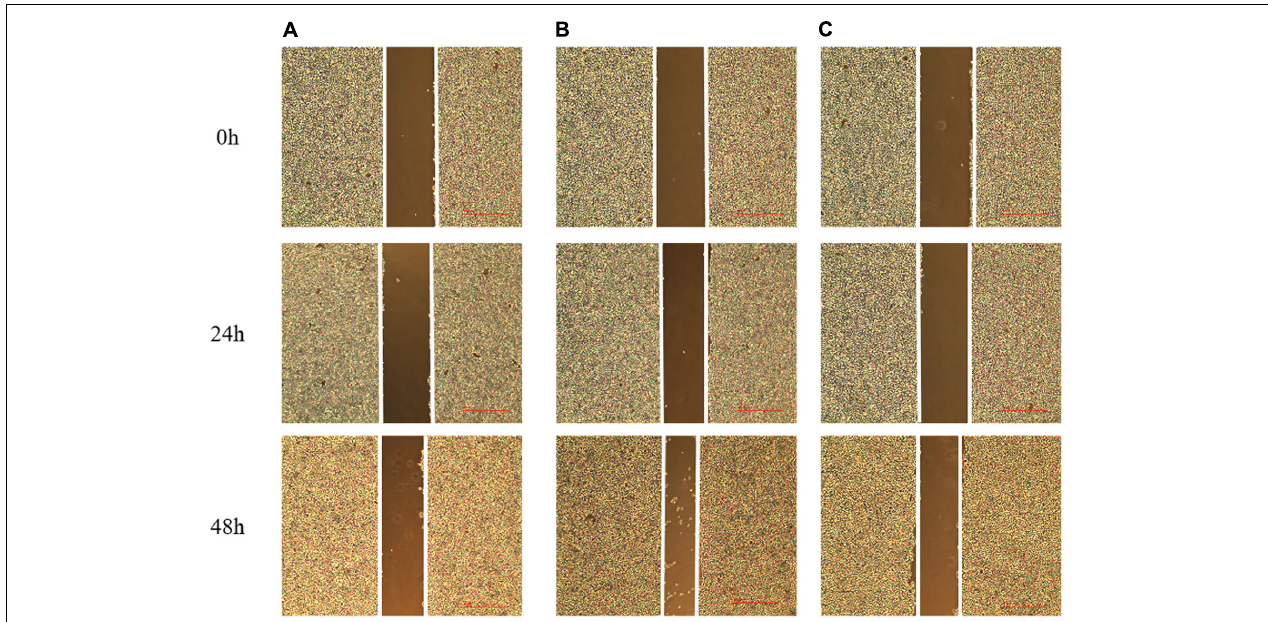
FIGURE 7 | The effect of lncRNA TPA overexpression and knockdown on the migration rate of MCF-7 cells [40 × , (A) Normal breast cancer cells, (B) lncRNA TPA overexpression cells, (C) lncRNA TPA knockdown cells].